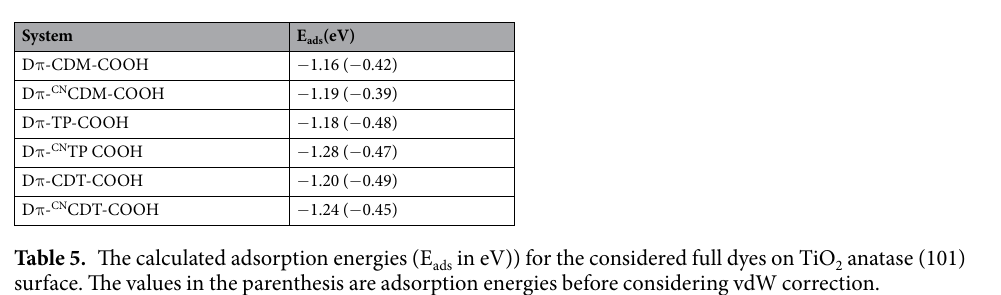
Table 5. The calculated adsorption energies (E ads in eV)) for the considered full dyes on TiO 2 anatase (101) surface. The values in the parenthesis are adsorption energies before considering vdW